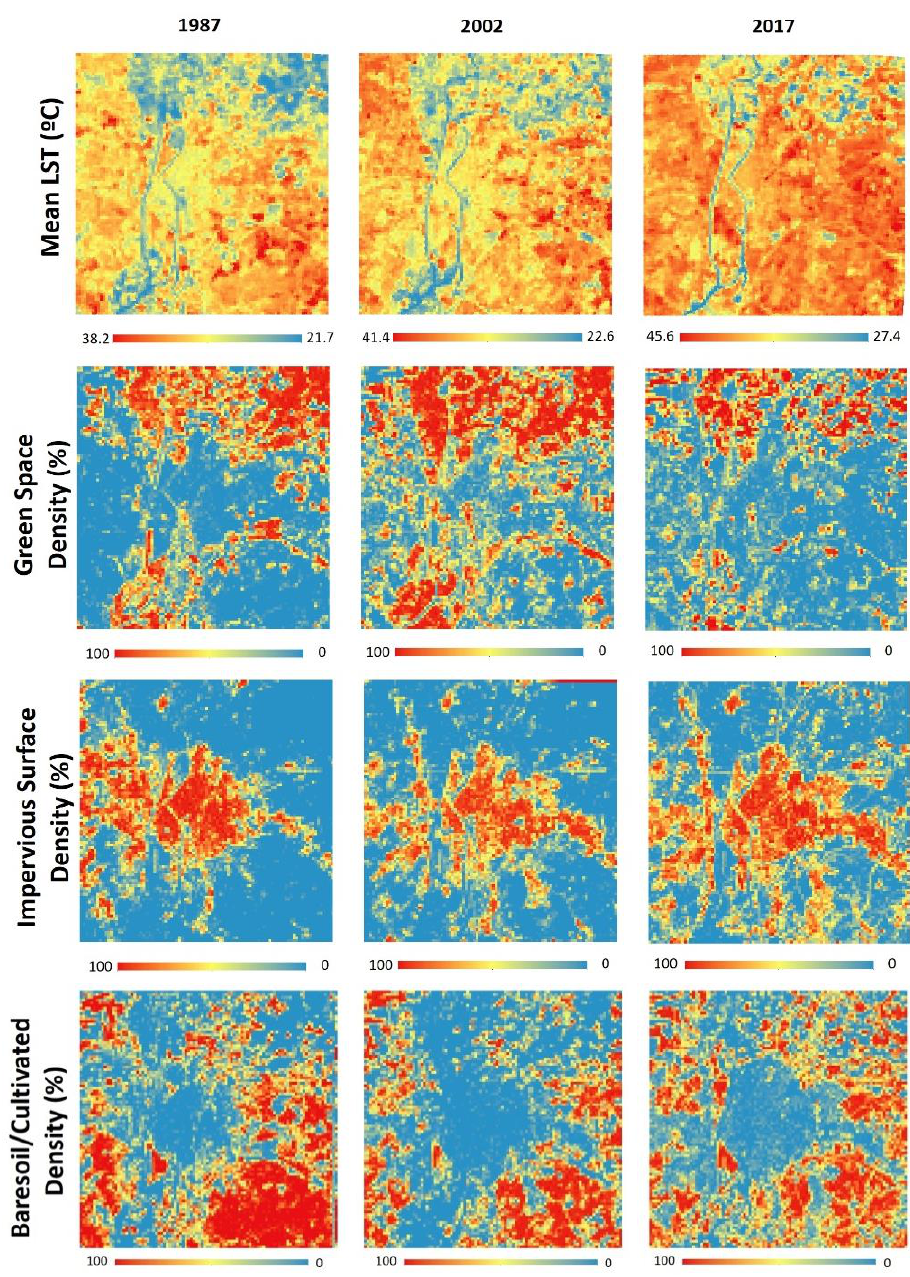
Figure 9. Graphical illustration of the polygon grid (210 m × 210 m), showing the maps of mean LST, impervious surface density, green space density and baresoil/cultivated.